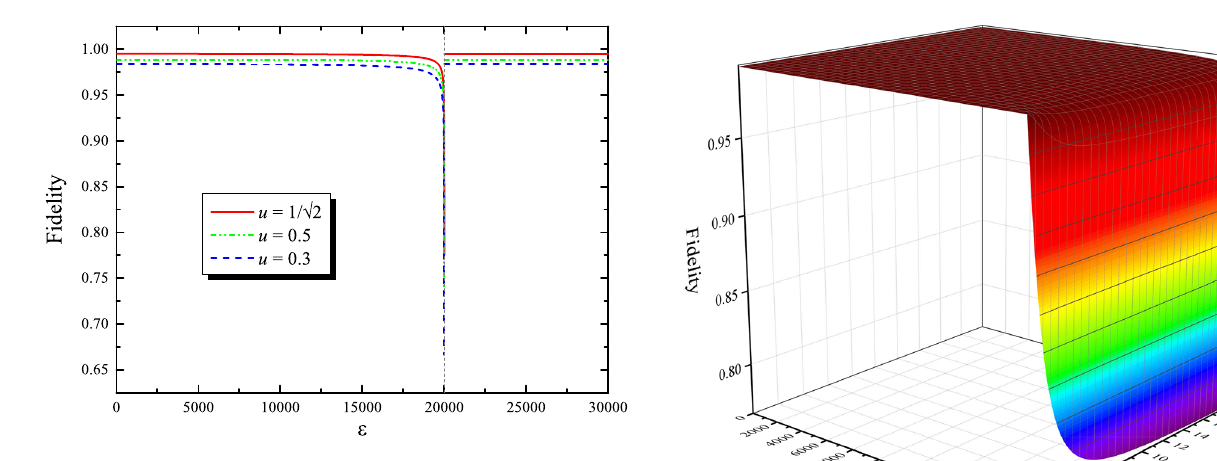
Fig. 10 The fidelity of quantum teleportation, F 3 as defined in (88), as a function of the volume ε of the expansion of the spacetime. The rapidity of the cosmic expansion is σ = 5. The parameters of the two originally entangled qubits A and B are the same. The energy gap of each of them is (cid:15) = 2, the inner product of the mode functions, defined in Eq. (21), is μ = 0 . 1. The mass of the scalarfieldparticleis m = 0 . 01. The state teleported from qubit C to B is u | 0 (cid:7) + v | 1 (cid:7)